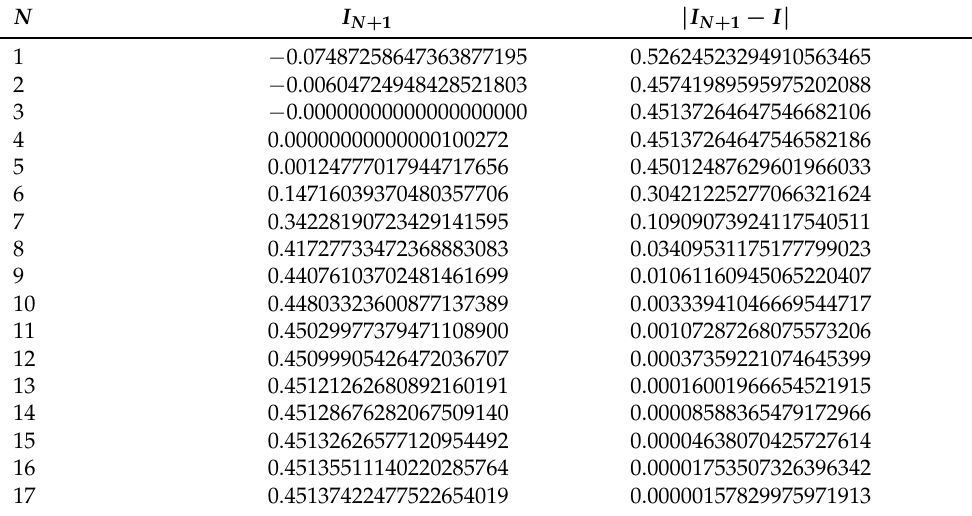
Table 2. The numerical results of the RO system using the double exponential (DE)-Sinc integration rule for ε = 10 − 5 based on the FPA.